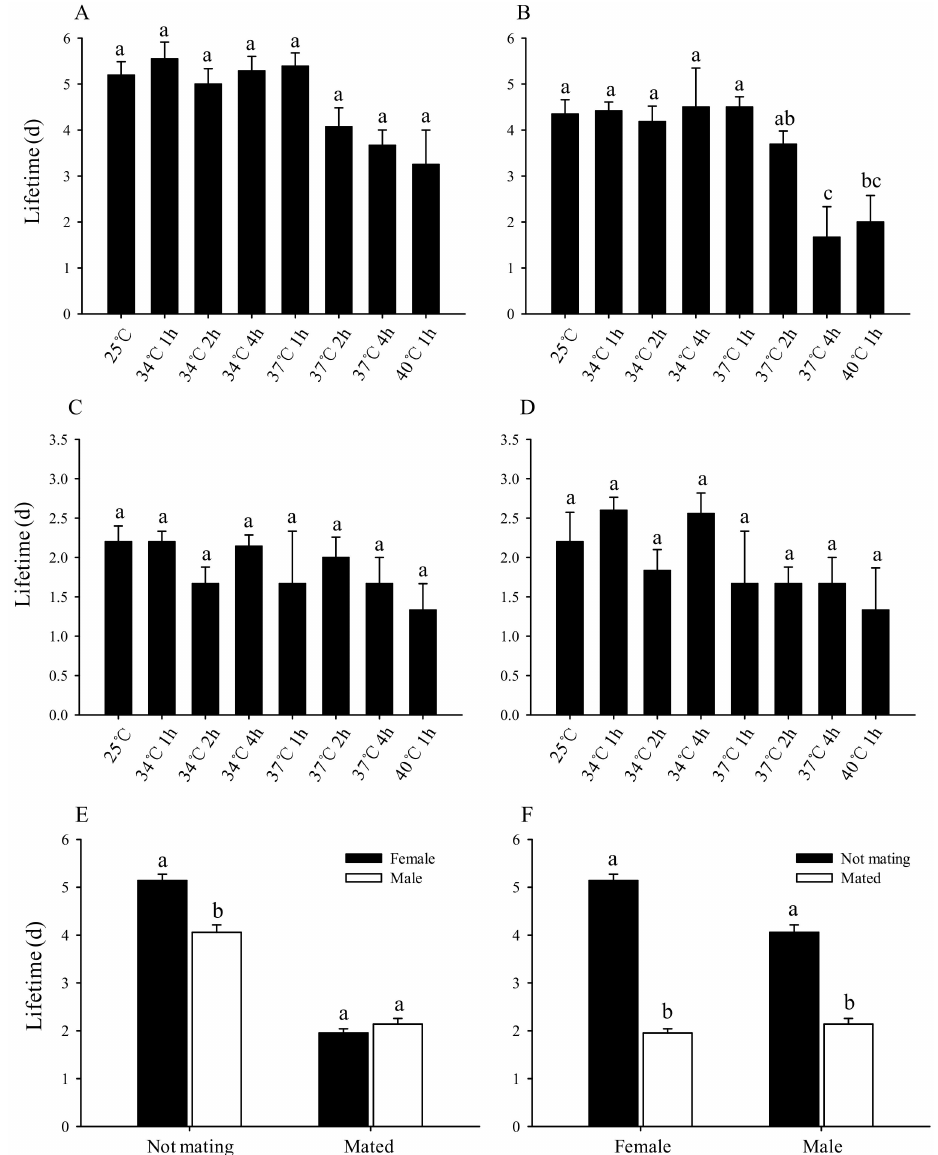
Figure 4. E ff ect of short-term high-temperature stress on the lifetime of Bradysia odoriphaga adults. ( A ) Unmated female adults, ( B ) unmated male adults, ( C ) mated female adults, ( D ) mated male adults, ( E ) lifespan comparison of male and female adults, and ( F ) lifespan comparison of unmated and mated adults. Values are means ± SD of five replicates. Within each panel, bars with di ff erent letters are significantly di ff erent according to Tukey’s test ( p < 0.05) ((d) = days). After emergence as adults, the lifespan of male and female adults was recorded daily. Adults were counted as dead if they did not move when gently touched with a brush. The total numbers (N) of female adults unmated were 143, 128, 133, 124, 105, 76, 7, and 20; the total numbers (N) of male adults unmated were 121, 124, 120, 124, 108, 80, 6, and 16 after third-instar larvae exposure to 25 ◦ C or 34 ◦ C for 1 h, 34 ◦ C for 2 h, 34 ◦ C for 4 h, 37 ◦ C for 1 h, 37 ◦ C for 2 h, 37 ◦ C for 4 h, and 40 ◦ C for 1 h, respectively. The total numbers (N) of female and male adults mated were 30 and 30, respectively, in the di ff erent test